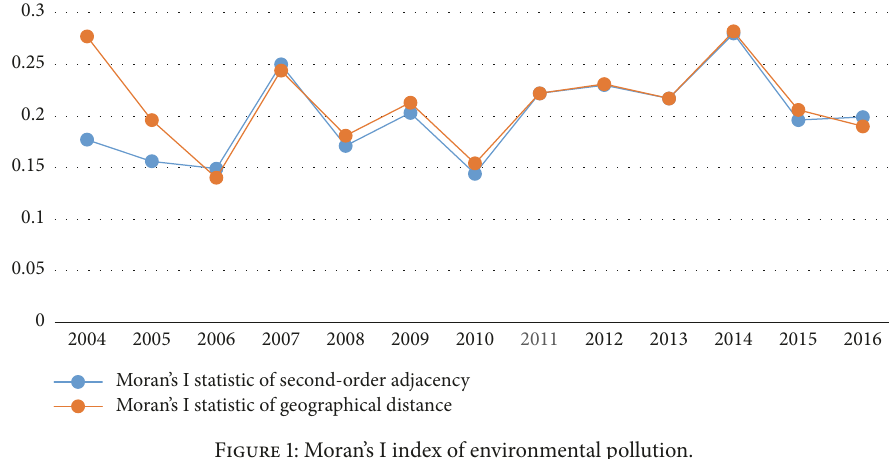
Figure 1: Moran’s I index of environmental pollution.